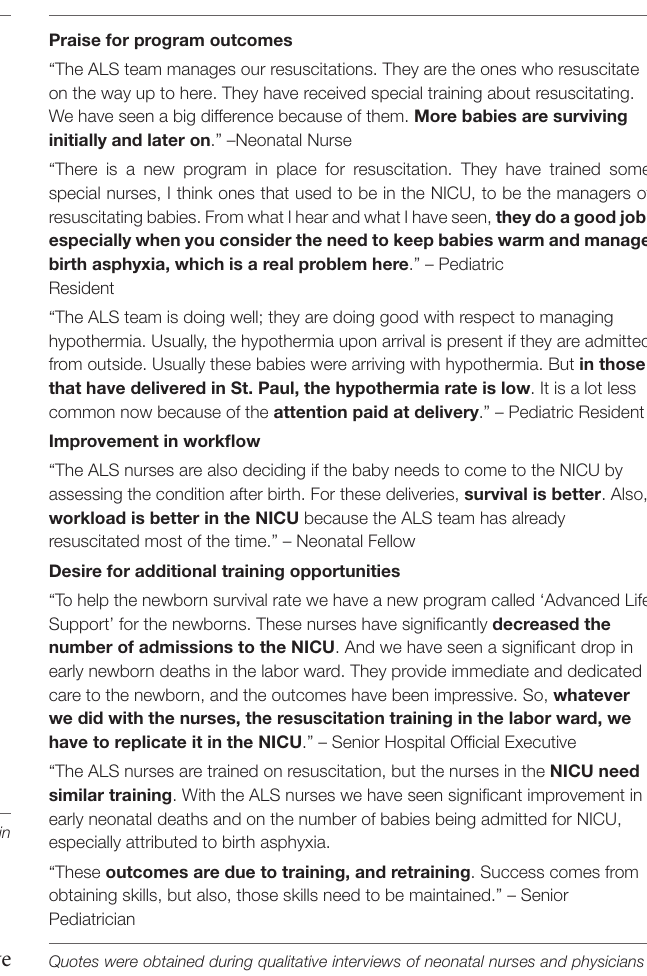
TABLE 5 | Quotes regarding the impact made by the Advanced Life Support (ALS) Team at St. Paul’s Hospital. Major Themes with Representative Quotes from Neonatal ALS Team Members